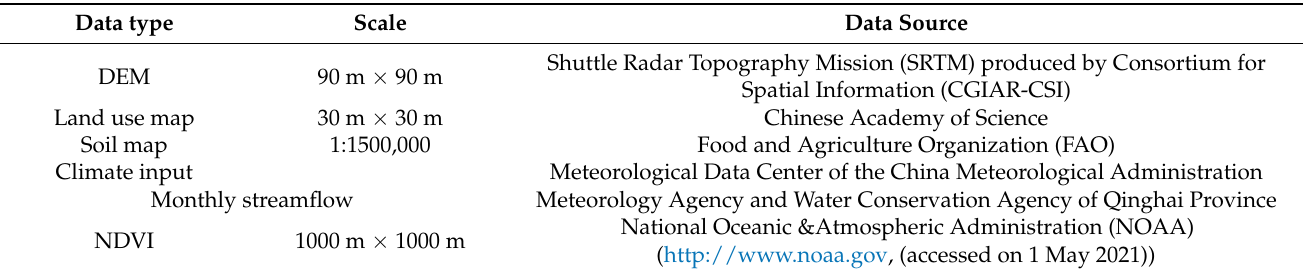
Figure 2. ( a ) Landuse and ( b ) soil classes maps used in Soil Water Assessment Tool (SWAT). Table 2. Data sources and Table 2. Data sources and description.